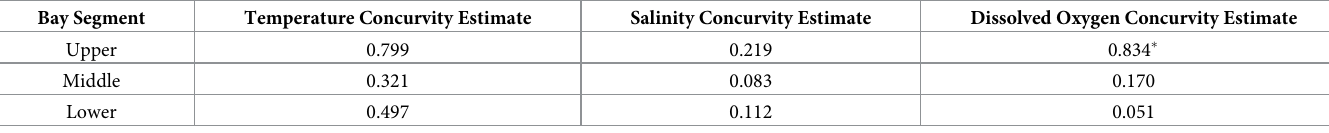
Table 3. Concurvity estimates for all predictor variables.